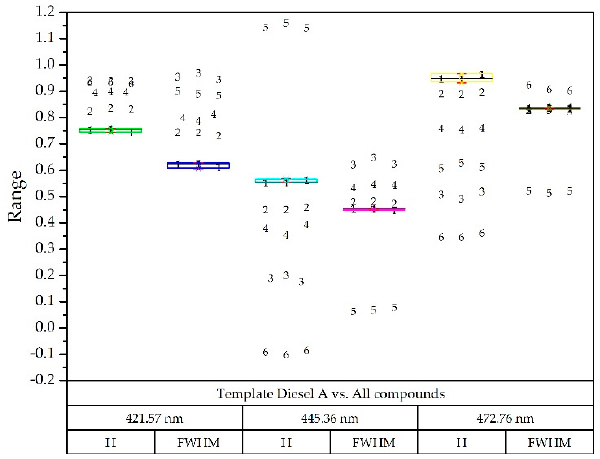
Figure 9. Box-plot diagram with reference diesel A (all of them at three optical powers): Diesel A (1), Diesel A with additives (2), Diesel B (3), Diesel C (4), Gasoline 95 (5) and Gasoline 98 (6).